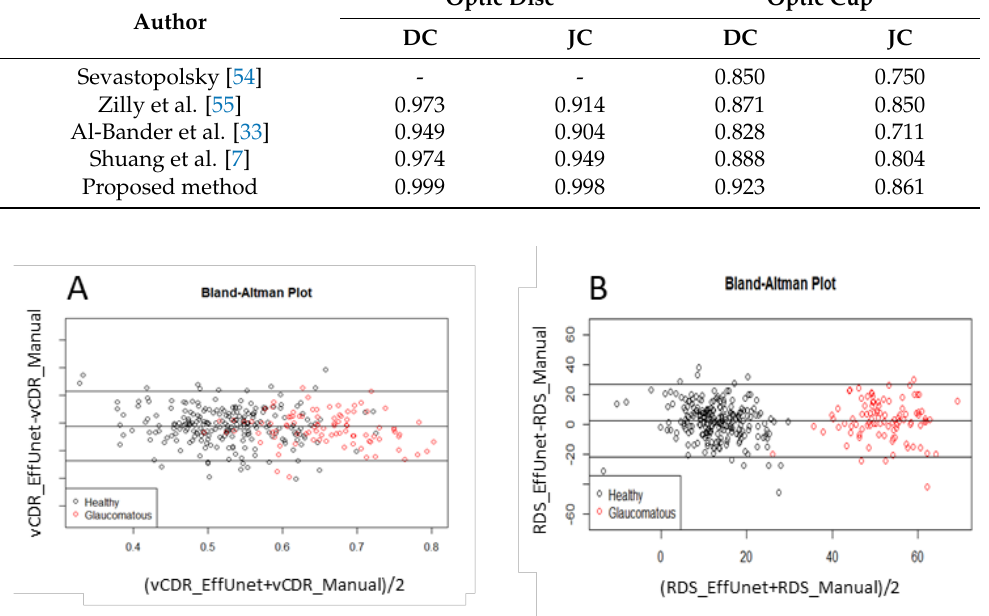
Figure 6. Reliability analysis of ( A ) vertical cup-to-disc ratio (CDR) and ( B ) rim deformation score (RDS) via Bland–Altman plot. Data used: segmentation trained on ORIGA-A, test set is ORIGA-B.